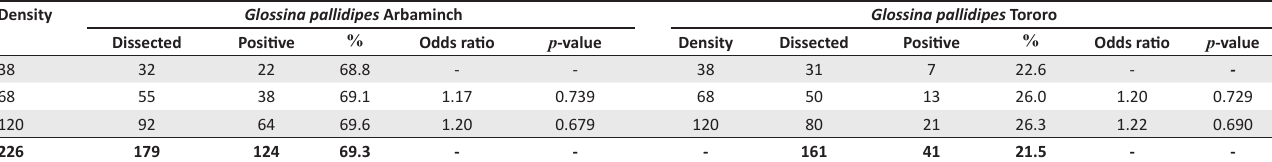
TABLE 2: Effect of stress (density) on prevalence of Glossina pallidipes salivary gland hyperplasia in Glossina pallidipes Arbaminch and Glossina pallidipes Tororo laboratory colonies (standard membrane feeding). Density